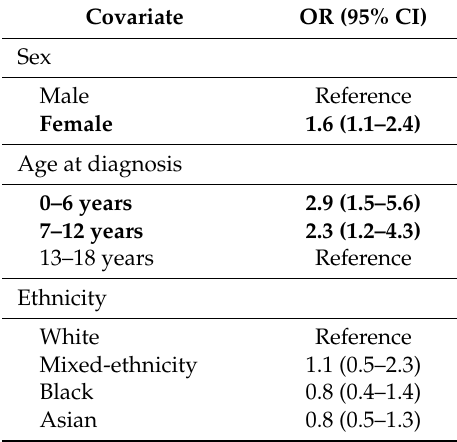
Table 2. Factors associated with diabetic ketoacidosis (pH < 7.3) at diagnosis of type 1 diabetes in 364 children and young people attending paediatric diabetes clinics in East